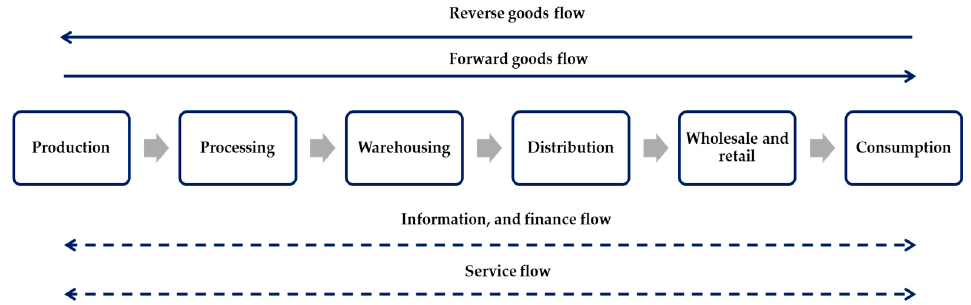
Figure 1. Basic steps in the logistics process.